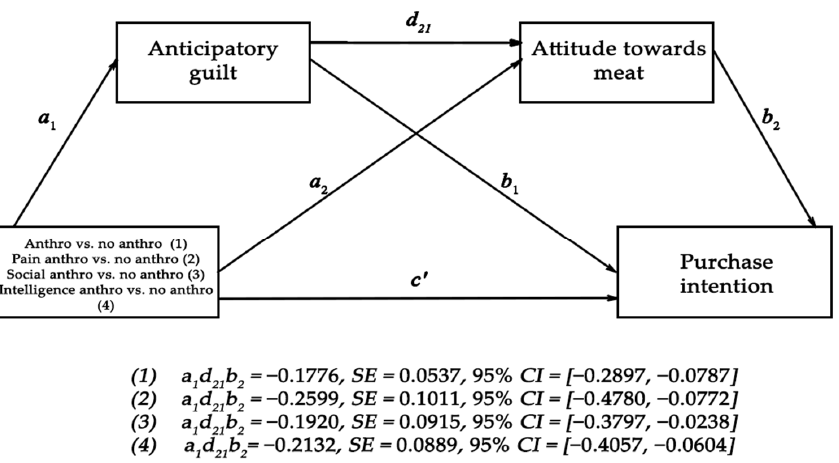
Figure 9. The effect of anthropomorphism (pain, pro-social and intelligence) vs. no anthropomor- phism (control and just cow) on purchase intentions is serially mediated via anticipatory guilt and attitude towards meat (Study 2).